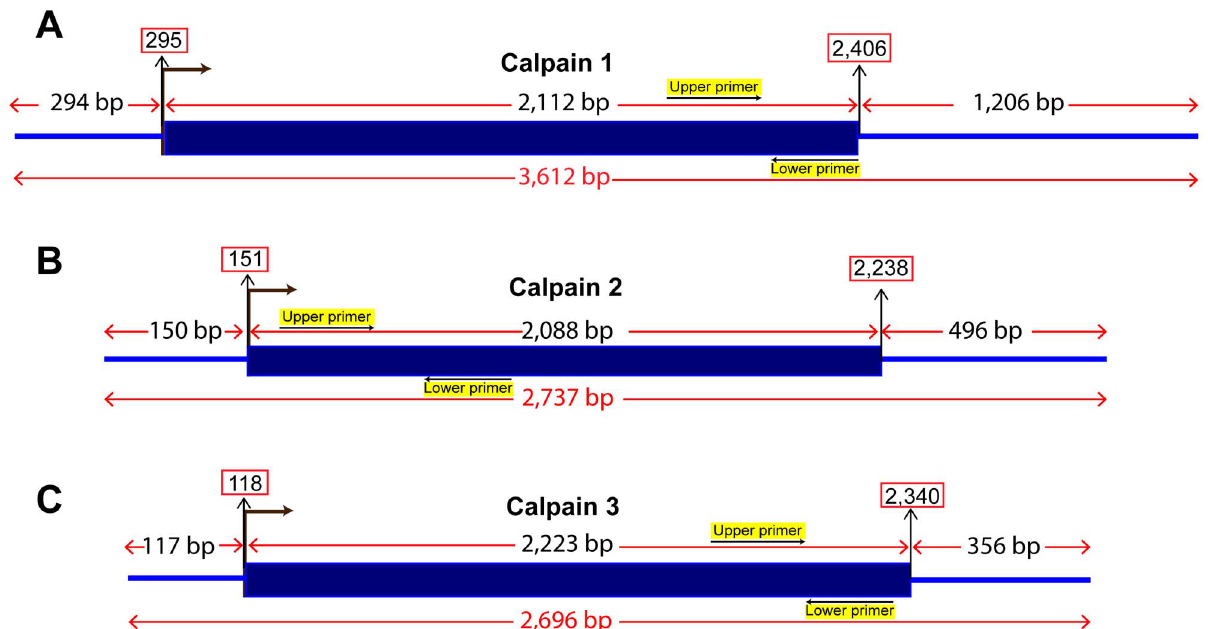
Figure 2. Schematic diagram of the full length cDNAs of channel catfish calpain catalytic subunits: (A) clpn1 ; (B) clpn2 ; (C) clpn3 . The positions of the primer sets used for real-time RT-PCR transcript quantification of each gene are indicated with the respective sequences.